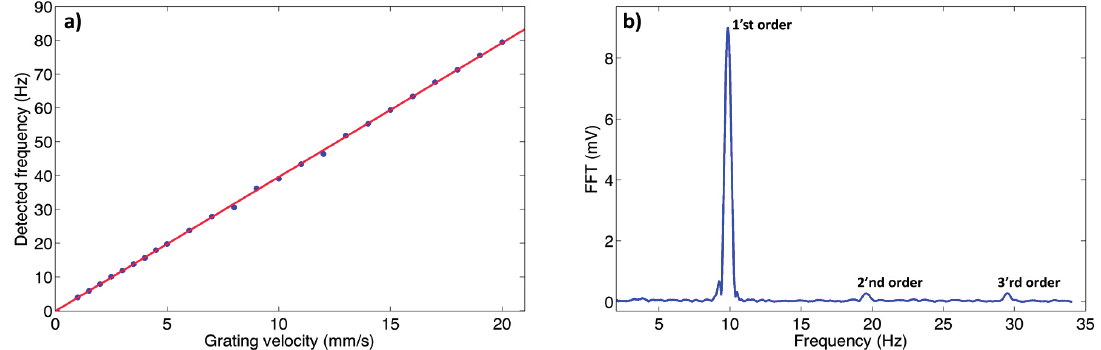
Figure 2. ( a ) Measured frequency shift as a function of the velocity of the grating. The data is based on measuring the first order beat signal; ( b ) Fourier transform of the signal measured by the detector for translation stage speed of 10 mm/s.